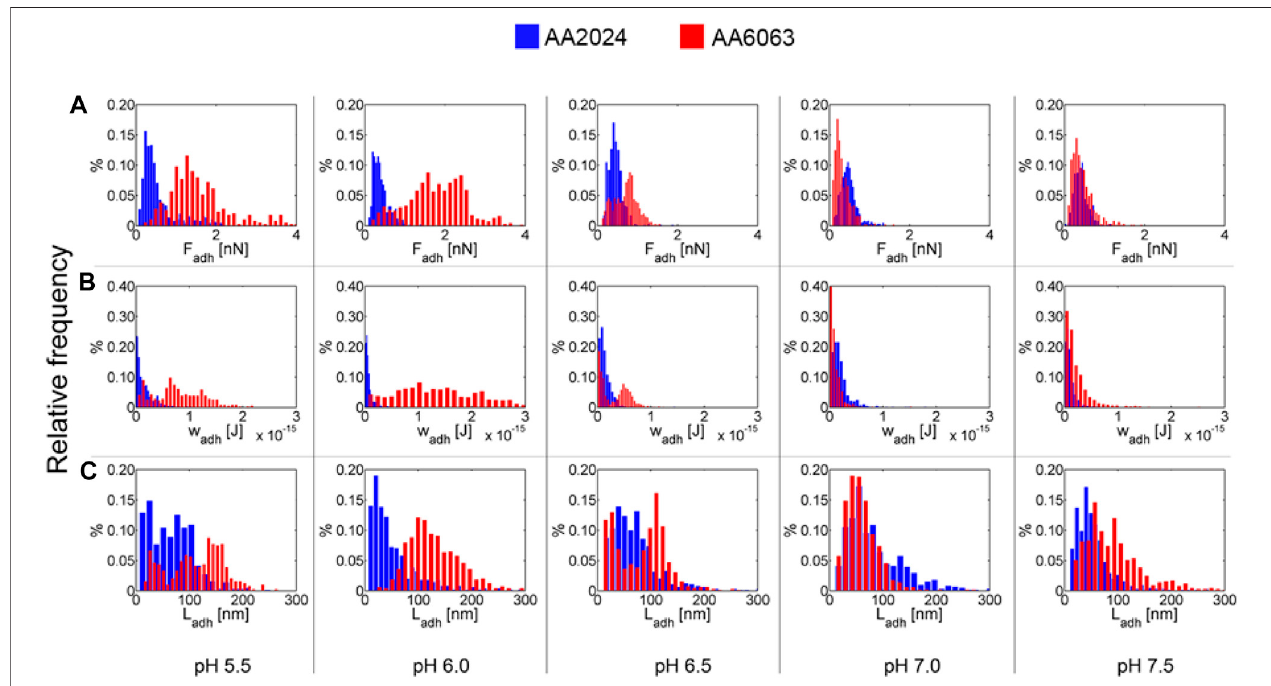
FIGURE7| Histogramsfor (A) adhesionforces,Fadh. (B) adhesionwork,Wadh,and (C) adhesionlength,Ladh,forAA2024andAA6063aluminum alloysurfaces as function of pH.